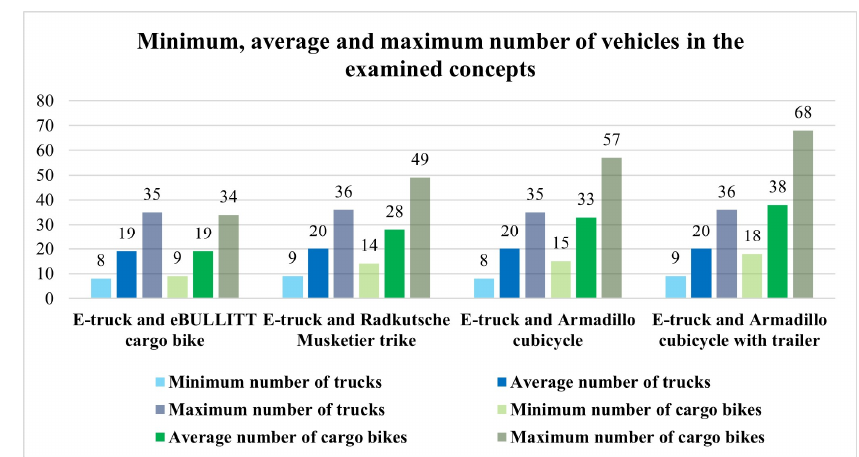
Figure 7. The number of vehicles, based on the simulation runs, for Budapest.